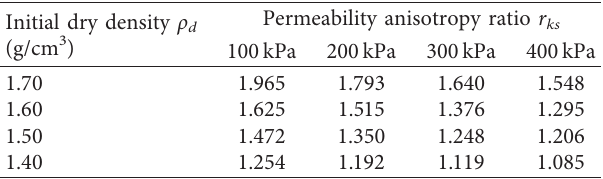
Table 9: Permeability anisotropy ratio of saturated compacted loess under K 0 consolidation.